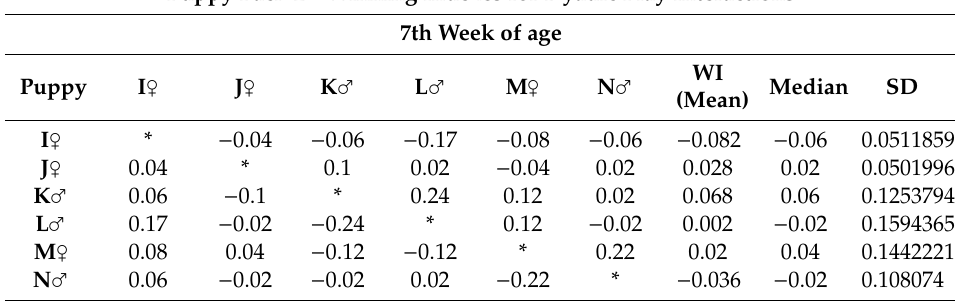
Table 6. Winning index calculated for each individual / each dyad (puppy pack 2). Winning index of 0 represents complete symmetry (each partner within dyad was in the position of a winner an equal amount of